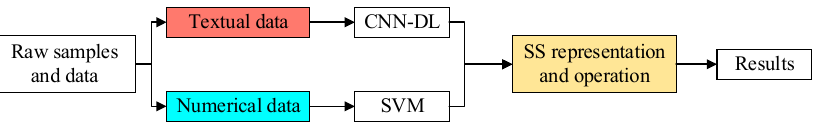
Figure 1. The framework of the novel integrated model (NIM).